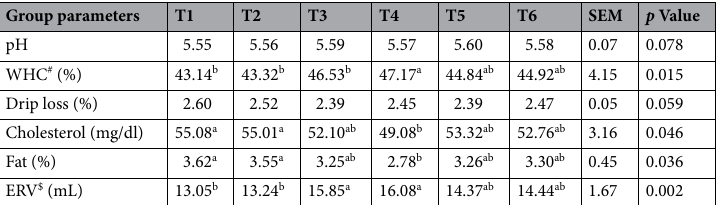
Table 3. Effects of dietary inclusion of prebiotics on physio- biochemical characteristics of meat in broiler chickens. T1 (no MOS/FOS/BMD), T2 (0.002% BMD), T3 (T1 + 0.1% MOS), T4 (T1 + 0.2% MOS), T5 (T1 + 0.1% FOS), T6 (T1 + 0.2% FOS). SEM = Standard error of mean; NS = Non-significant; n = 15. Mean values bearing the same superscript in a row did not differ significantly ( p < 0.05). # WHC = Water holding capacity, $ ERV = Extract release volume.